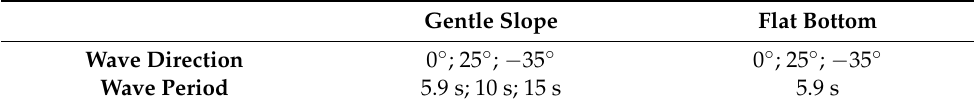
Table 1. Scenarios analysed in the numerical